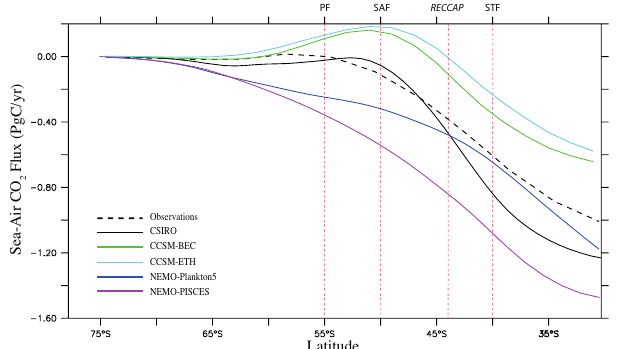
Fig. 5. The cumulative, zonally integrated, annual mean CO 2 up- Figure 5 The cumulative, zonally-integrated, annual mean CO 2 uptake (30 ° S-75 ° S 1218$ take (30–75 ◦ S integrating from the south) from the biogeochemical integrating from the south) from the biogeochemical ocean models and observations 1219$ ocean models and observations (dashed line) (PgCyr − 1 ). Overlain (dashed line) (PgC/yr). Overlain are the nominal positions of the major Southern 1220$ are the nominal positions of the major Southern Ocean fronts and Ocean fronts and the RECCAP boundary at 44 ° S. Negative values reflect flux into the 1221$ the RECCAP boundary at 44 ◦ S. Negative values reflect flux into the